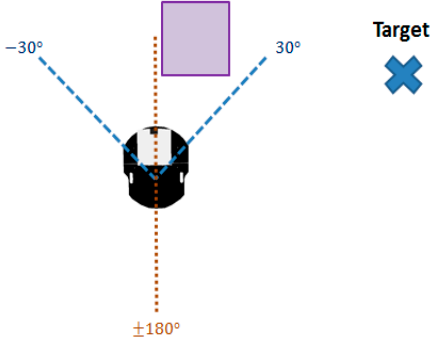
Figure 7. Illustration of fatal error.